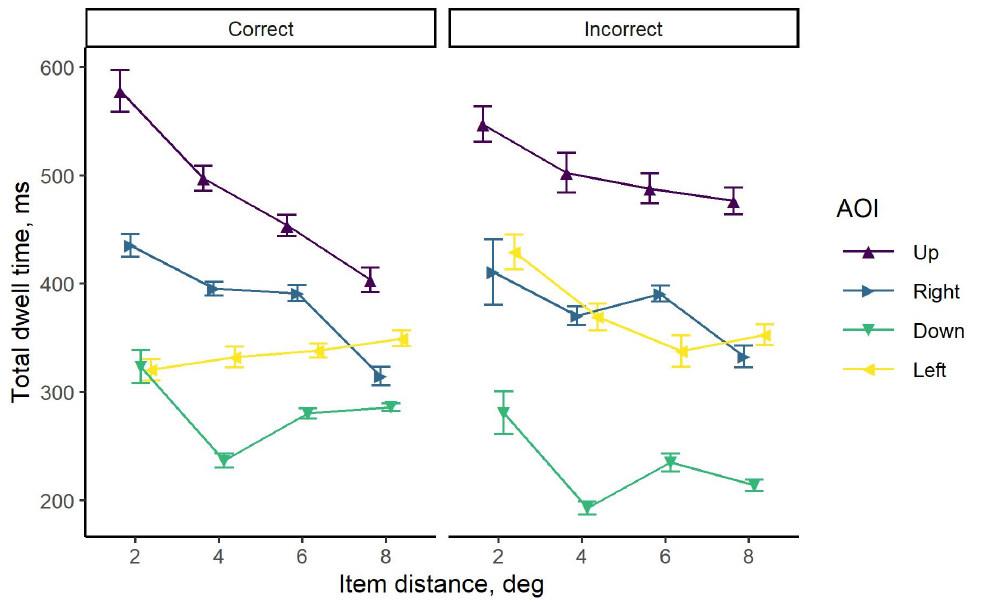
Figure 5. Mean total dwell times for all subjects when responding to 2D images (target-absent trials) with items presented at four positions (up, right, down, and left) and four distances from the plane center (2°, 4°, 6°, and 8°) on the multi-plane display. The bars represent the group standard